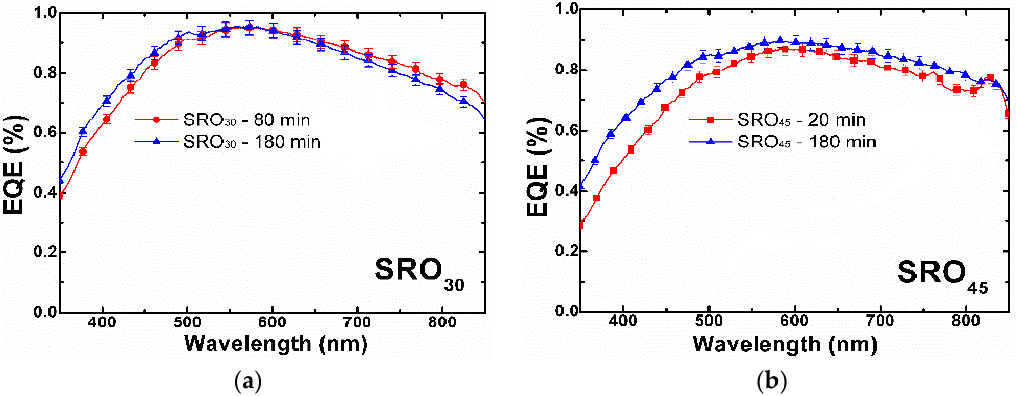
Figure 3. Experimental EQE measured for UV photodetectors covered with SRO 30 and SR 45